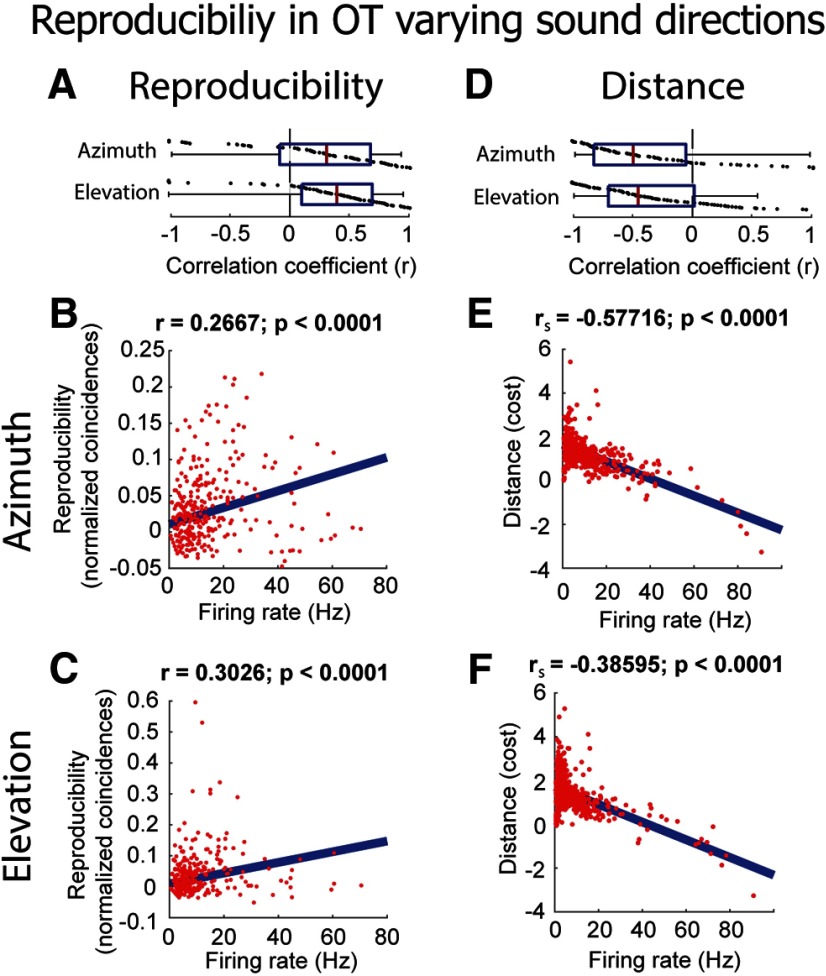
Relationship between reproducibility and firing rate in OT (N = 93) varying spatial location (same format as in Fig. 4). A, Correlation coefficients (r) of reproducibility against firing rate for each neuron for varying azimuth (top) and elevation (bottom). B, C, Reproducibility as a function of firing rate for all neurons while varying azimuth (B) and elevation (C). Firing rates and reproducibility are normalized by the maximum and minimum for each neuron. D–F, Same description as for A–C but for the corrected Victor–Purpura distance metric.